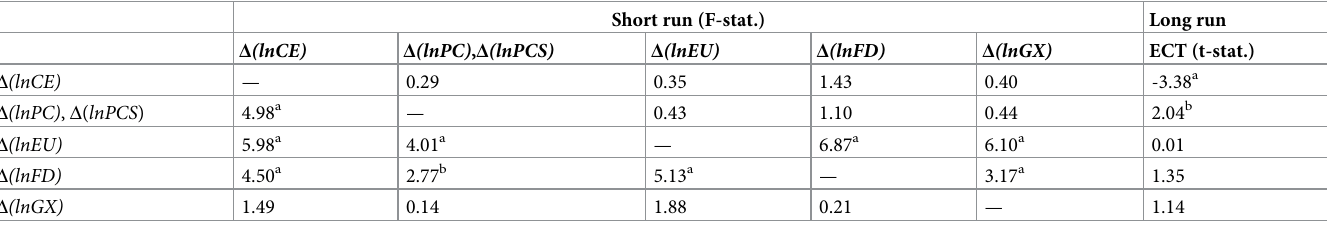
Table 4. Causality results based on VECM.